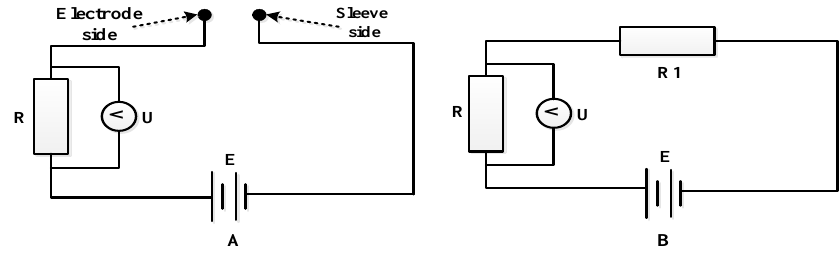
Figure 2. Circuit diagram of the bubble sensor. ( A ) The detection circuit for a single electrode; ( B ) the simplified circuit.